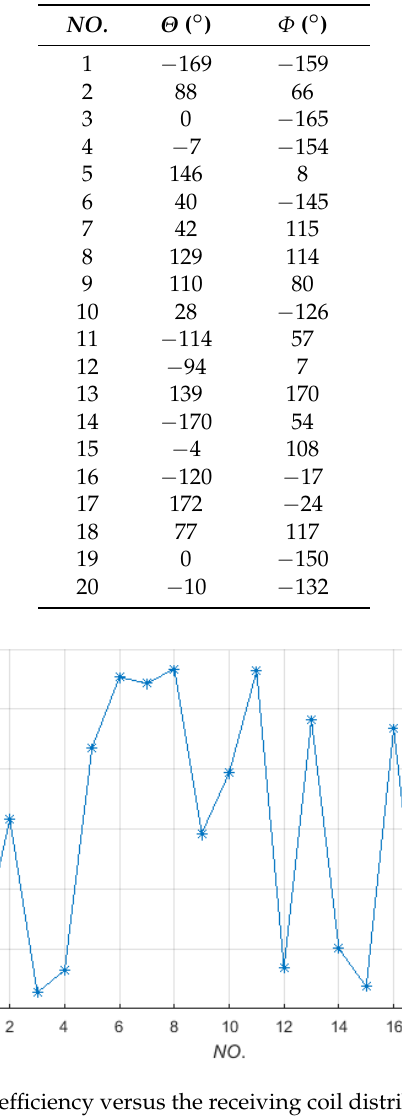
Table 2. Random sampling values of parameter set ( Θ , Φ ).